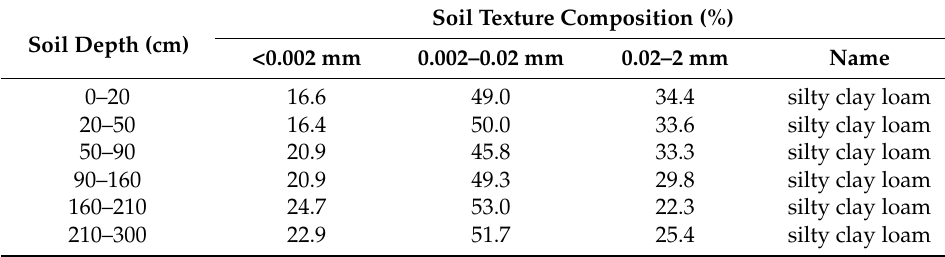
Table 2. The physical parameters of the soil.